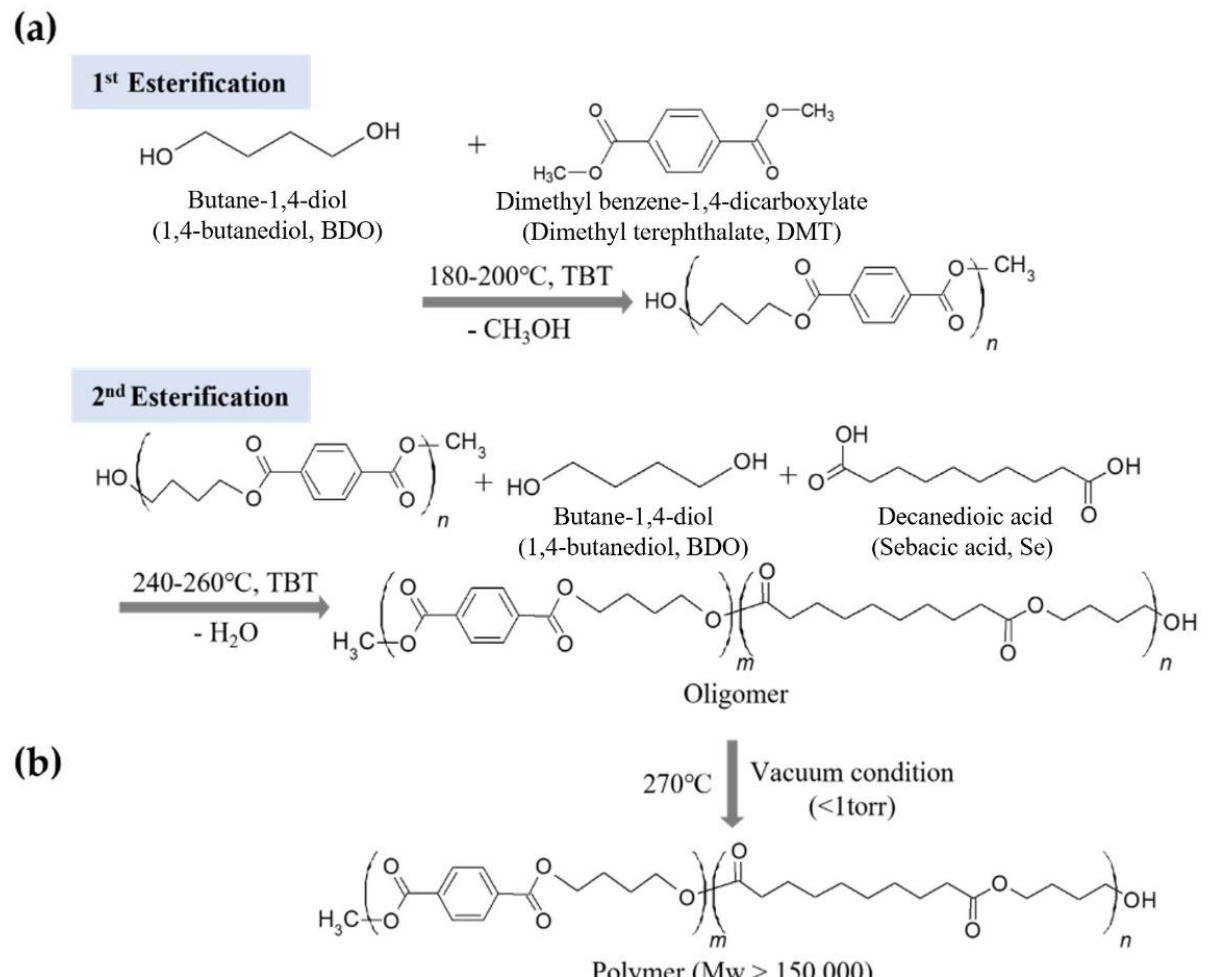
Figure 9. Procedure for the synthesis of PBSeT. ( a ) Step 1: esterification, and ( b ) step 2: polyconden- sation. Table 4. Formulations of PLA-g-MAH samples.